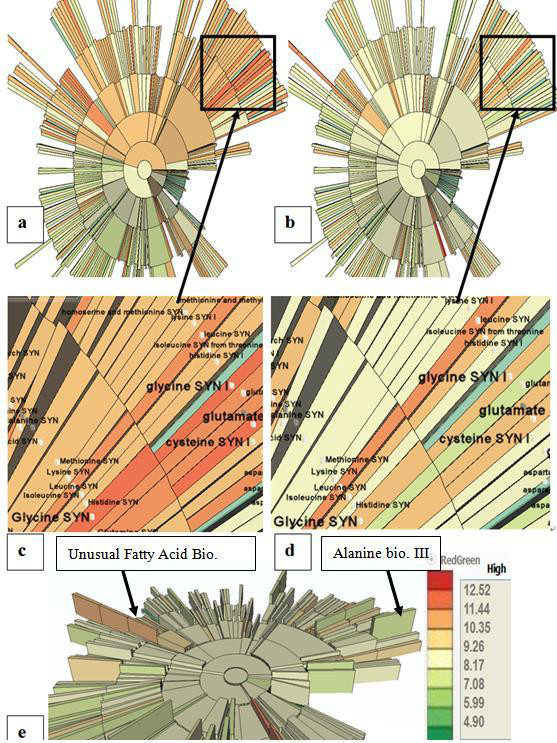
Experimental values mapped onto the pathway ontology. Average expression values are shown for each condition. The color of each region reflects the differential expression for these pathways. The orange and red colors in condition 1 show that these categories have much higher expression values in condition 1 (a) than in condition 2 (b). The differences between these two conditions are more obvious when using animation in MetNetGE. (c)(d) show the details in the glycine biosynthesis categories. When the view is tilted (e), the categories with high Coefficient of Variation (CoV) is shown by their higher height.